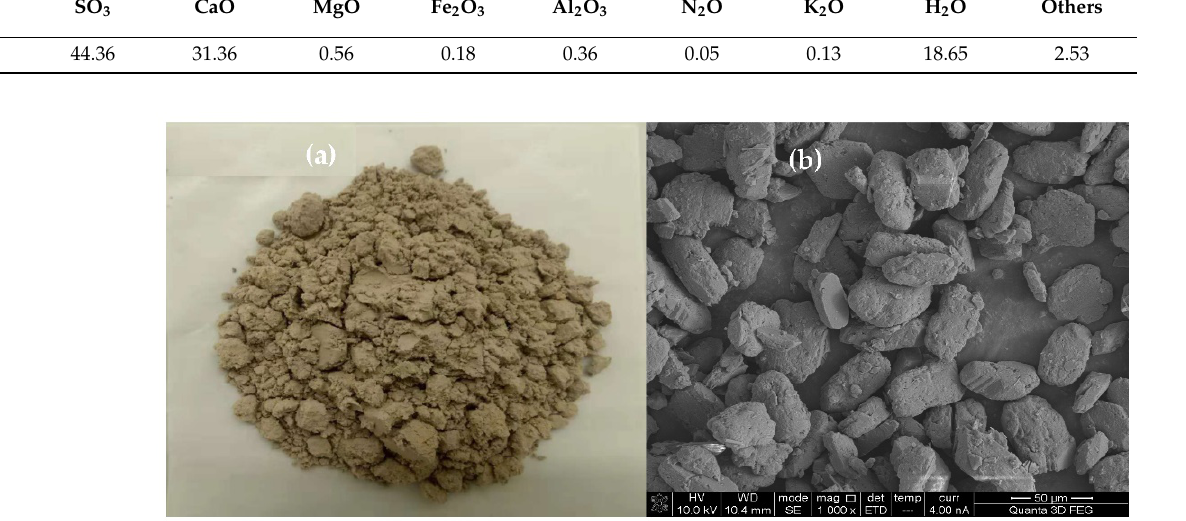
Figure 1. Apparent morphology ( a ), and SEM image ( b ), of FGD gypsum.